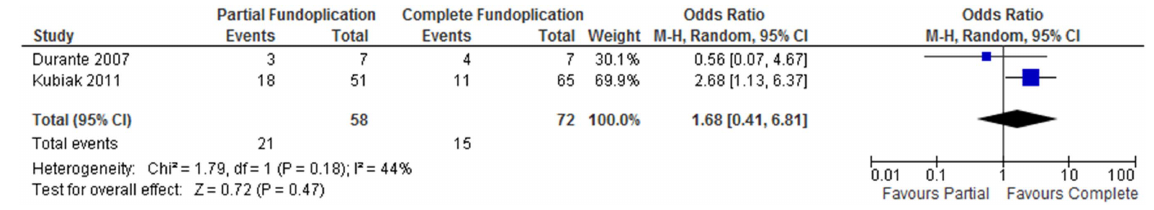
Figure 4. Recurrence of GERD following partial versus complete fundoplication in neurologically impaired patient subgroup (RCT).